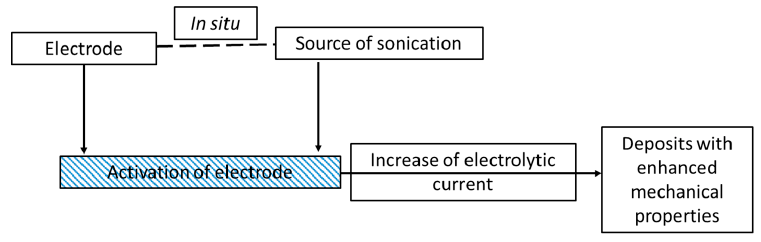
Figure 11. A schematic representation of the synthesis of the materials by means of the sonoelectrodeposition